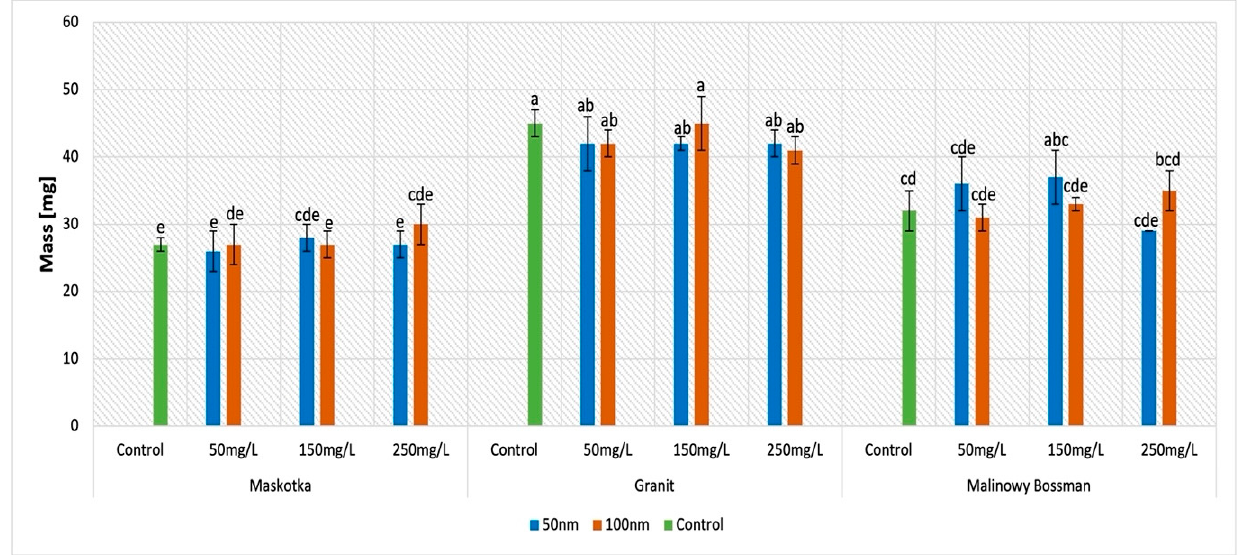
Figure 7. Effect of zinc oxide NPs on the dry weight of germination of tomato seeds after 5 days of incubation. All data are the mean of 3 replicates and vertical bars demonstrate standard deviation (±SD). Different letters indicate the significant differences for p -value ≤ 0.05 (Table A5).